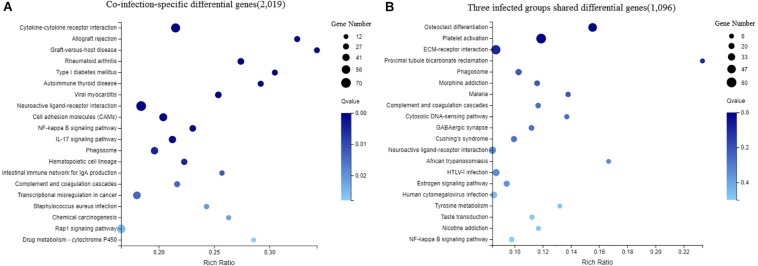
Enriched bubble chart showing the enrichment of the KEGG Pathway in three dimensions. X-axis is enrichment ratio, Y-axis is KEGG Pathway. Bubble size indicates the number of genes annotated to a KEGG Pathway. Color represents the enriched Q-value. The darker the color, the smaller the Q-value. (A) The top 20 KEGG enrichment results of co-infection-specific differential genes (2,019). (B) The top 20 KEGG enrichment results of the differential genes shared by the three infected groups (1,096).